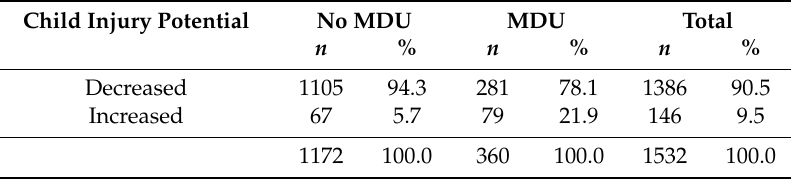
Table 3. Child injury potential by minutes of no mobile device use (No MDU) compared with minutes of mobile device use (MDU).